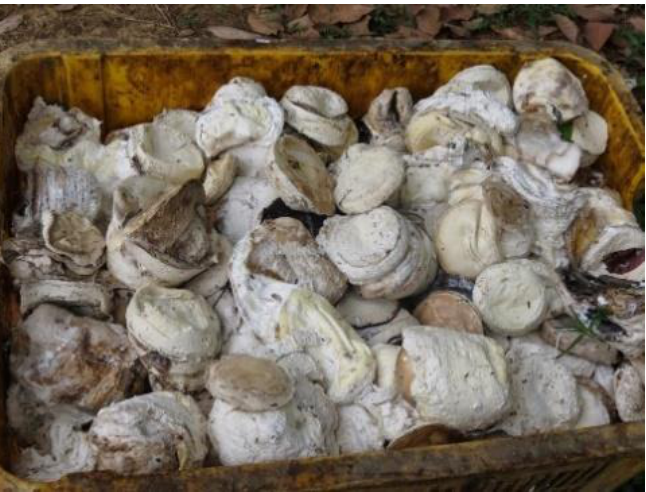
Figure 1. Cup lump rubber.